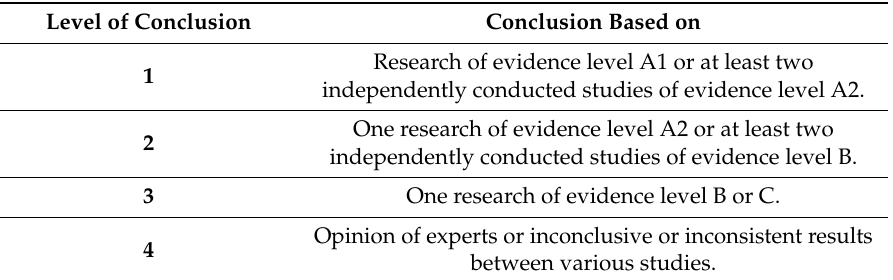
Table 6. Level of